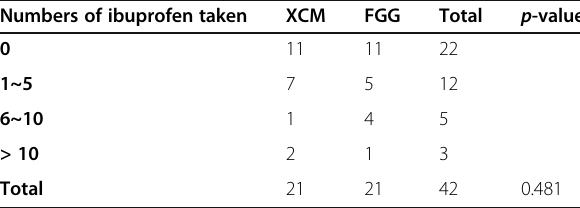
Table 4 Numbers of ibuprofen taken during the early healing